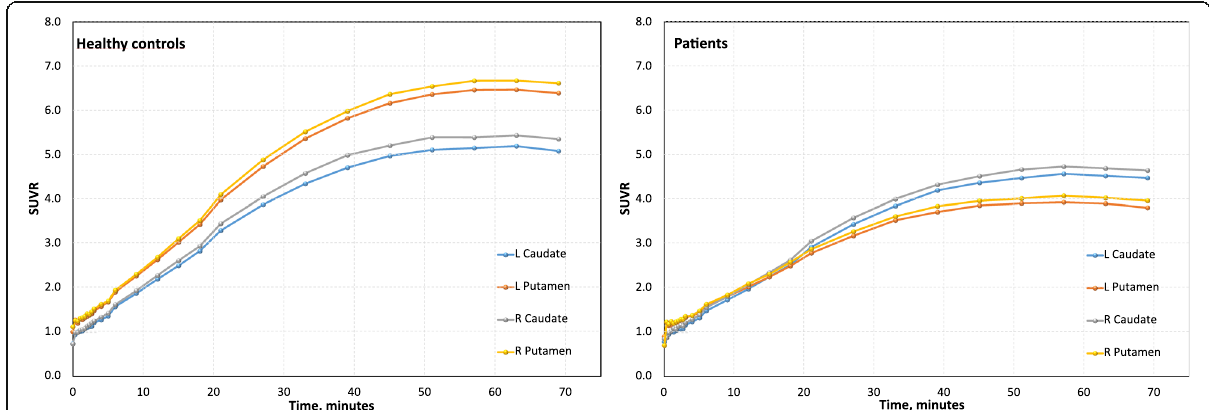
Fig. 4 SUVR as a function of time. SUVR (activity/cerebellum ratio) as a function of time for FE-PE2I in healthy controls (left) and PS patients (right). The SUVR reaches an equilibrium 50 min post